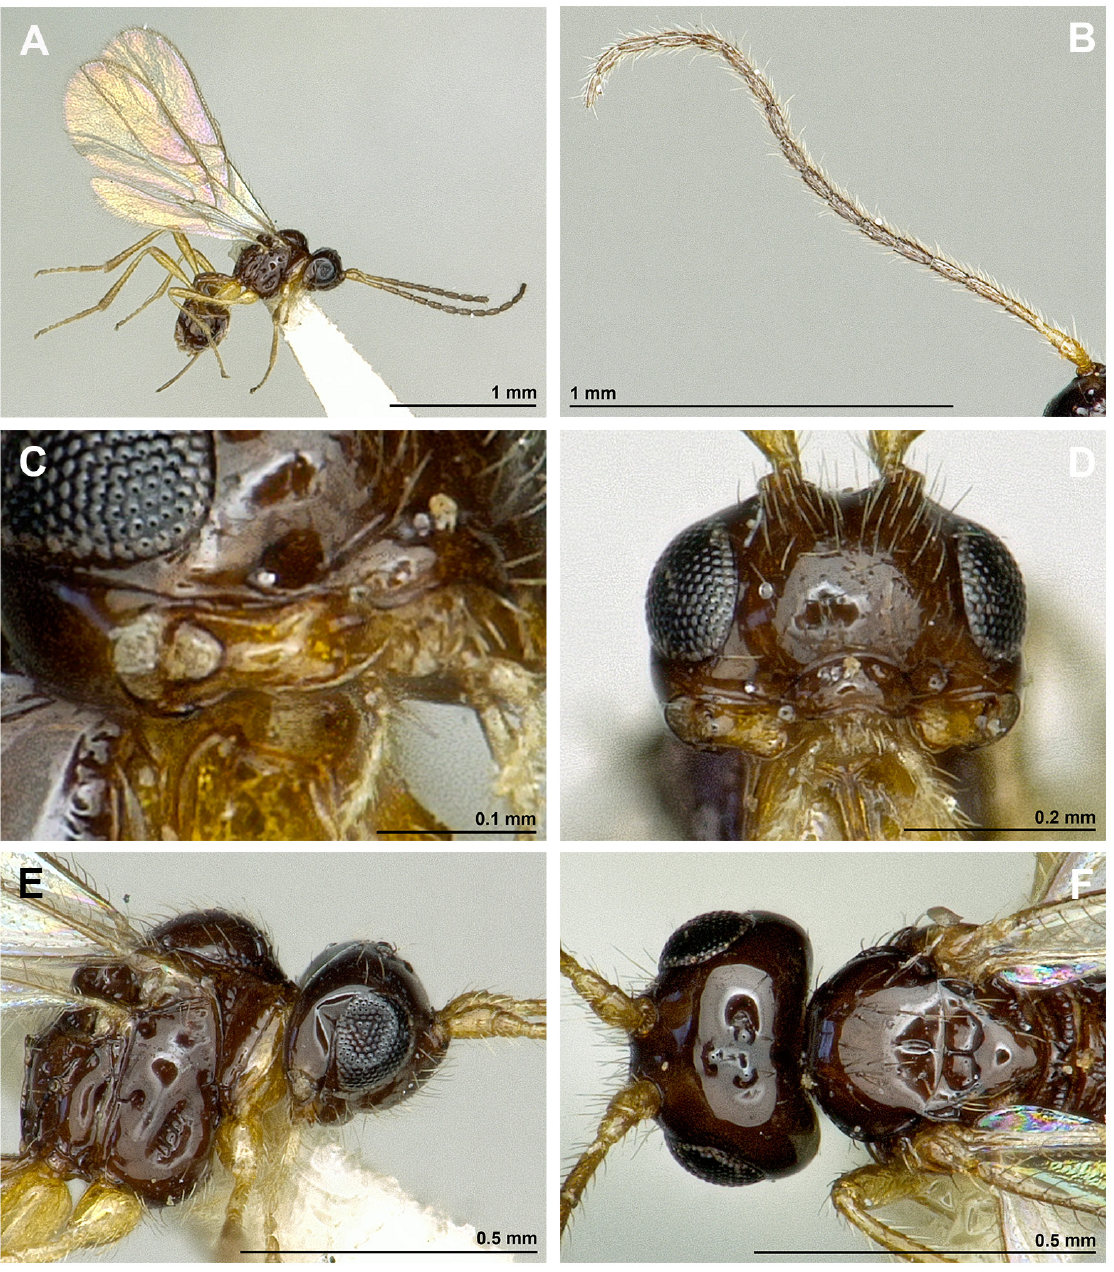
Fig. 6. Synaldis longiflagellaris Peris-Felipo, sp. nov., ♀. A . Habitus, lateral view. B . Antenna. C . Mandible. D . Face, front view. E . Head and mesosoma, lateral view. F . Head and mesonotum, dorsal